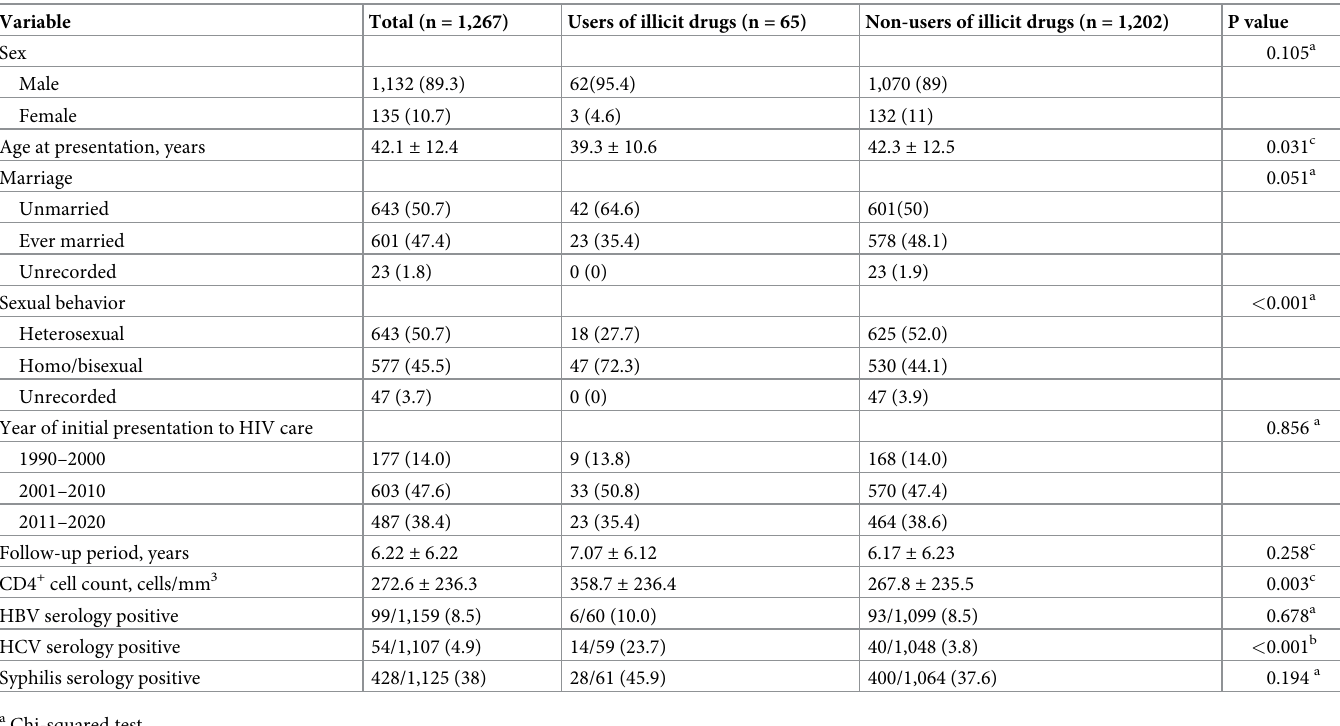
Table 1. Baseline characteristics of HIV-infected patients analyzed by comparing illicit drug users and